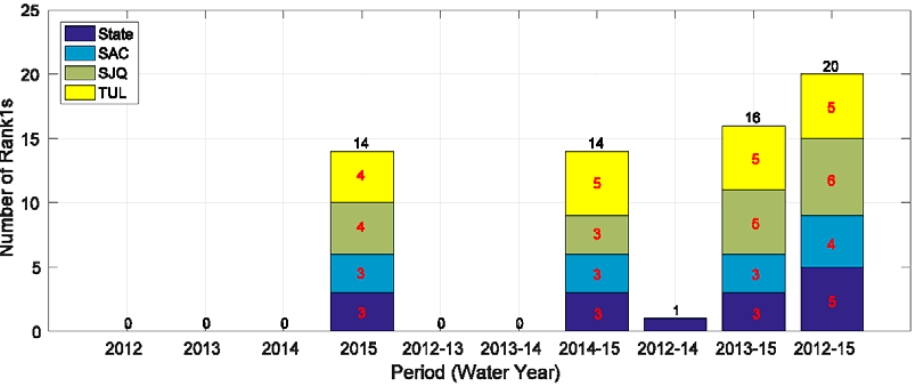
Figure 8. Number of variables (out of 28) ranked first within different periods from 2012–2015.